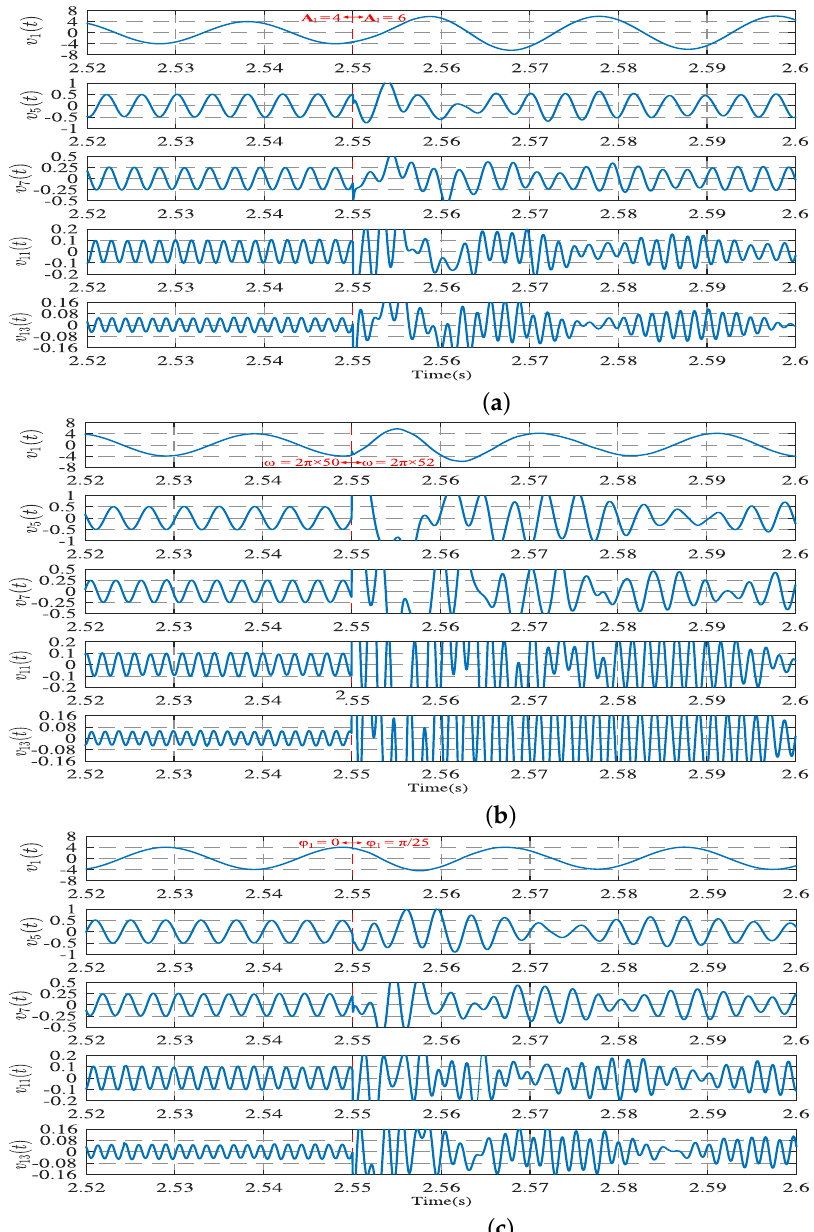
Figure 17. Observations of each harmonic from the composite observer before and after amplitude, frequency, and phase jumps: ( a ) Harmonics before and after amplitude jump; ( b ) harmonics before and after frequency jump; and ( c ) harmonics before and after phase